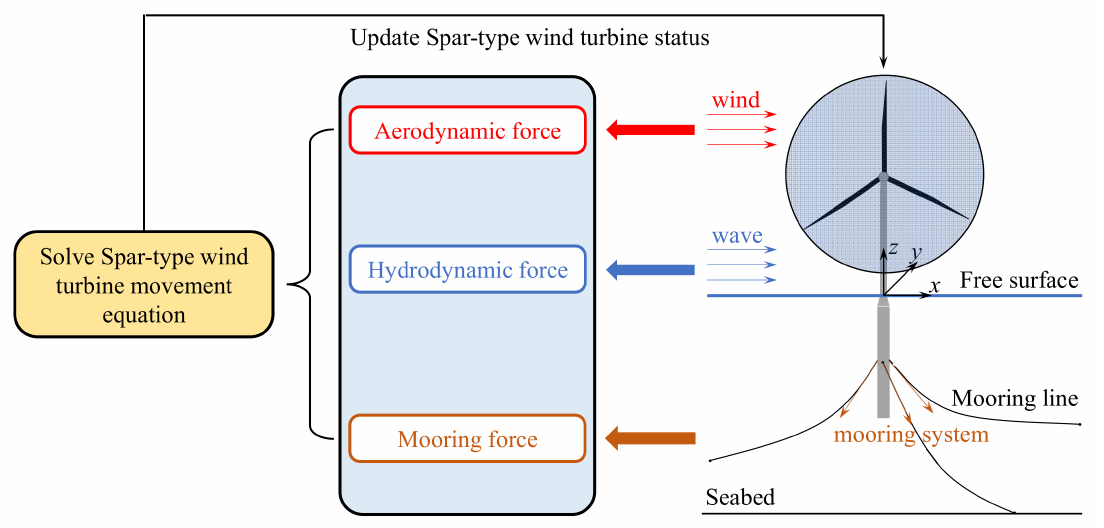
Figure 3. Flow chart of Spar-type wind turbine dynamic response